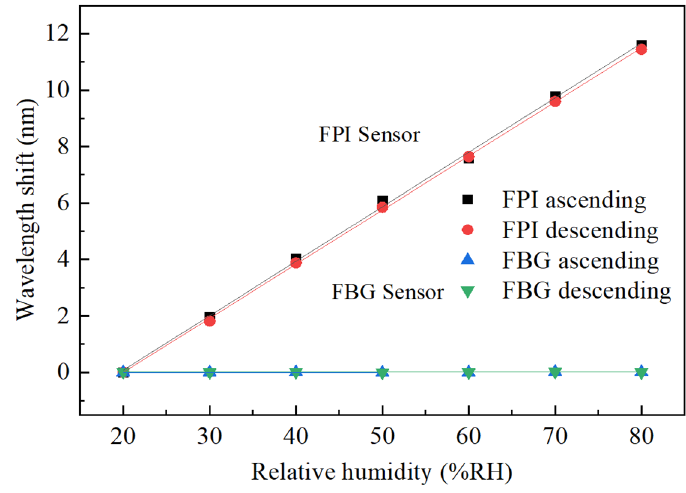
Figure 5. Wavelength shift against relative humidity.